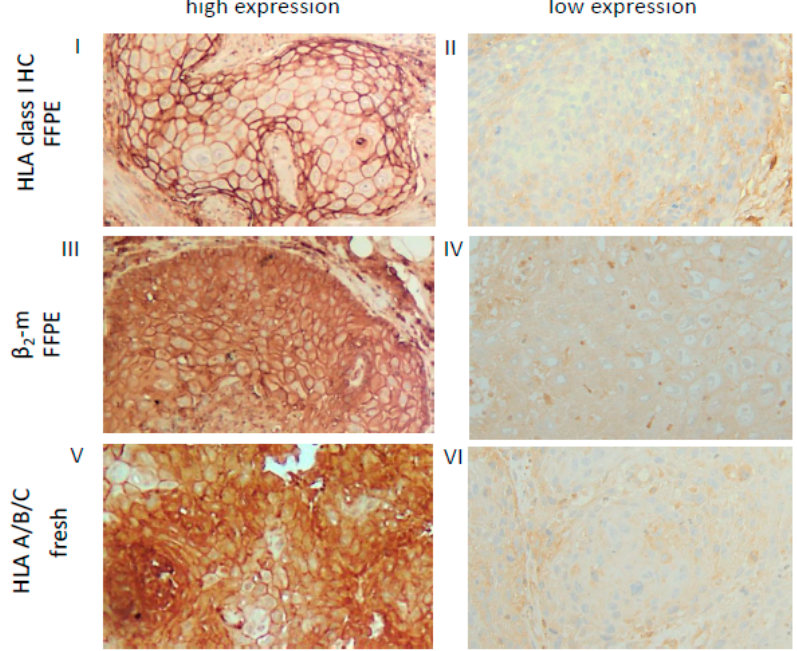
Figure 1. Representative high and low staining patterns of OSCC lesions for HLA-I HC, β 2 -m and the trimeric HLA-I complex. Immunohistochemical analyses using antibodies directed against HLA class I HC (FFPE, I , II ), β 2 -m (FFPE III , IV ) and the trimeric HLA class I A/B/C complex (W6/32; fresh frozen, V , VI ). Representative cases with a high ( I , III ) or low ( II , IV ) cytoplasmic and membranous expression of HLA class I HC and β 2 -m in FFPE samples are shown and compared to a staining of the trimeric HLA class I complex ( V , VI ) on fresh frozen tissues. Each image was done at a 200× resolution.